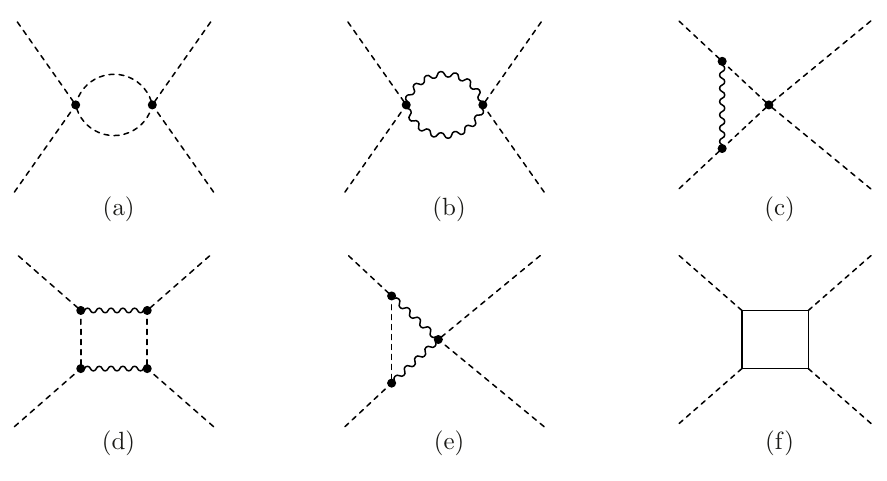
Figure 1. The Feynman diagrams that determine δ ˜ λ ijkl defined in equation (3.8). The lines have the usual meaning: full, wiggly and dashed lines indicate fermions, vector bosons and scalars,